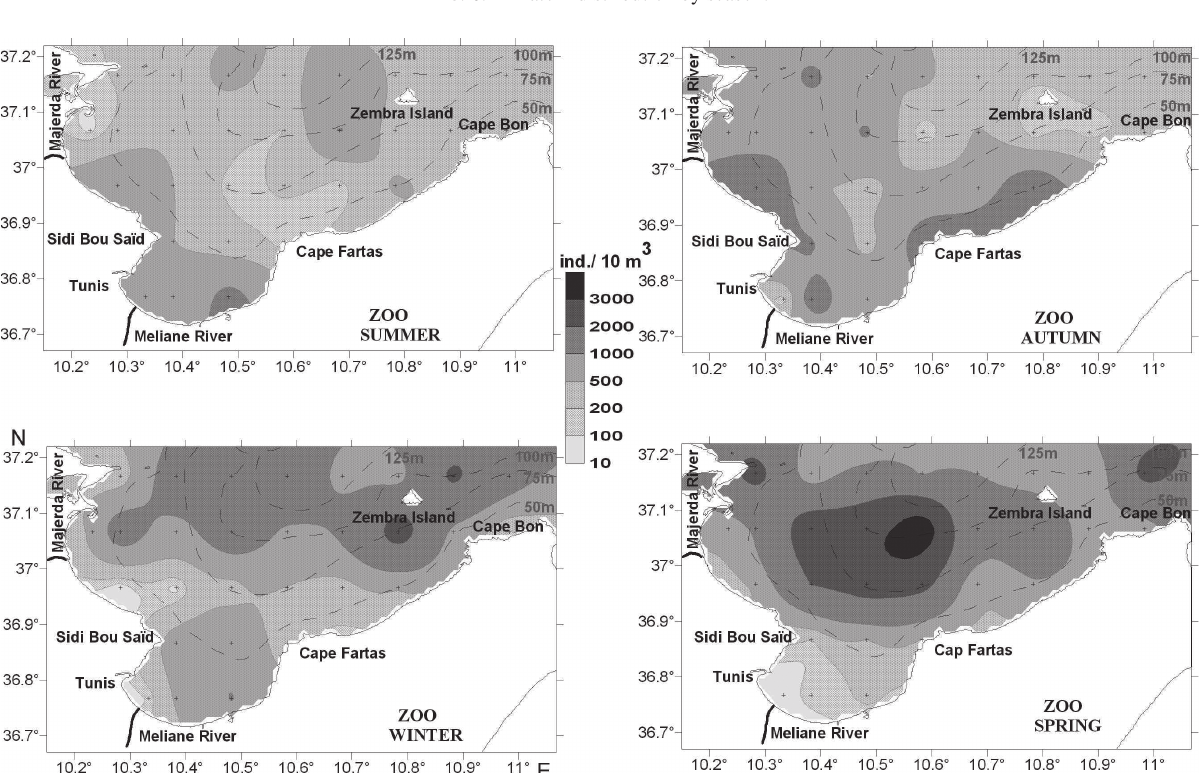
Fig. 7. – Zooplankton distribution by